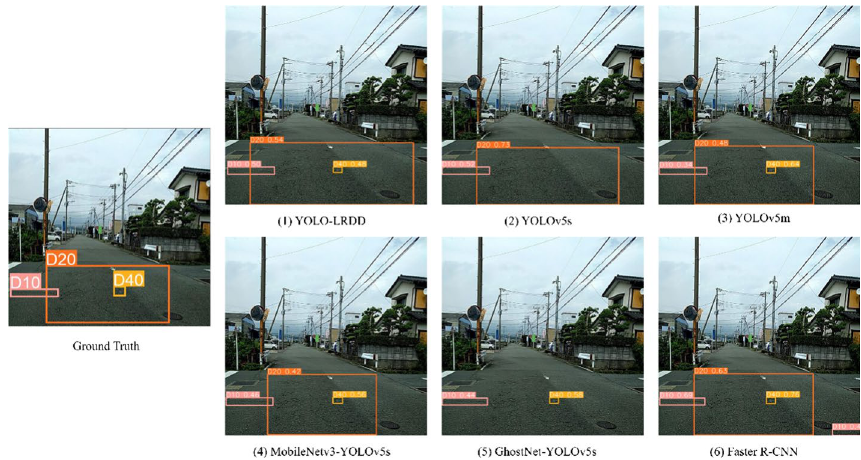
Fig. 11 Comparison of the detection in multi damaged road